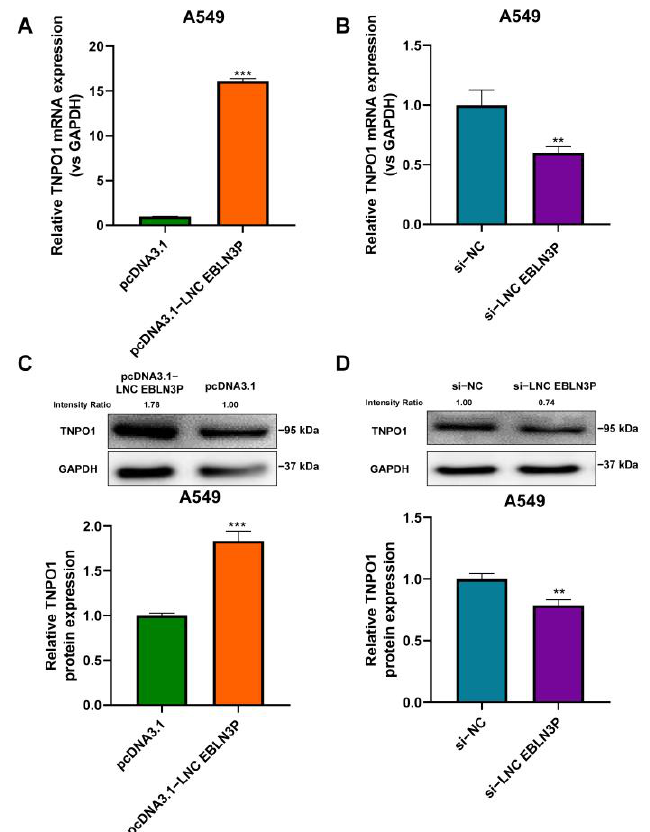
Figure 4. LNC EBLN3P positively regulates TNPO1 expression in lung cancer cells. ( A , C ) The overexpression of LNC EBLN3P increases both TNPO1 mRNA and protein levels in A549 cells. ( B , D ) The knockdown of LNC EBLN3P decreases both TNPO1 mRNA and protein levels in A549 cells. Data shown in A – D represent the mean ± SD ( n = 3). ** p < 0.01, *** p < 0.001.